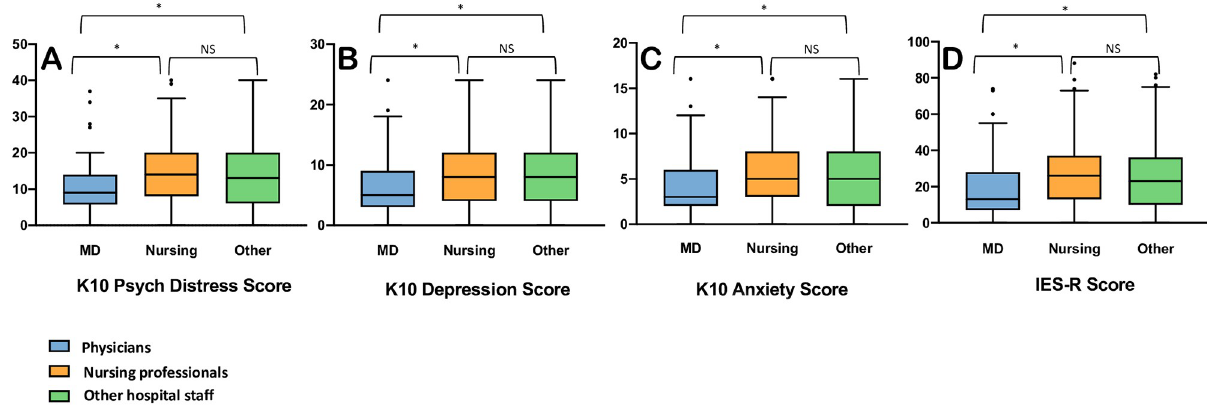
Fig 3. Box plots with Tukey whiskers demonstrating scores on psychological questionnaires among hospital workers during the COVID-19 pandemic by professional role. [ � indicates a significant difference was found in the pairwise comparisons, p < 0.005; Not significant (NS) , p > 0.05]. K10 : Kessler Psychological Distress Scale; IES-R : Impact of Events Scale Revised. A . K10 psychological distress—Physicians vs. Nursing: H = -121.24, p < 0.001; Physicians vs. Other: H = -103.43, p = 0.002; Other vs. Nursing: H = 17.81, p = 0.33. B . K10 Depression subscore—Physicians vs. Nursing: H = -116.20, p < 0.001; Physicians vs. Other: H = -104.50, p = 0.001; Other vs. Nursing: 11.702, p = 0.64. C : K10 Anxiety subscore—Physicians vs. Nursing: H = -117.69, p < 0.001; Physicians vs. Other: H = -96.49, p = 0.003; Other vs. Nursing: H = 21.20, p = 0.25. D : IES-R total score—Physicians vs. Nursing: H = -134.66, p < 0.001; Physicians vs. Other: H = -109.69, p < 0.001; Other vs. Nursing: H = 24.97, p = 0.16.